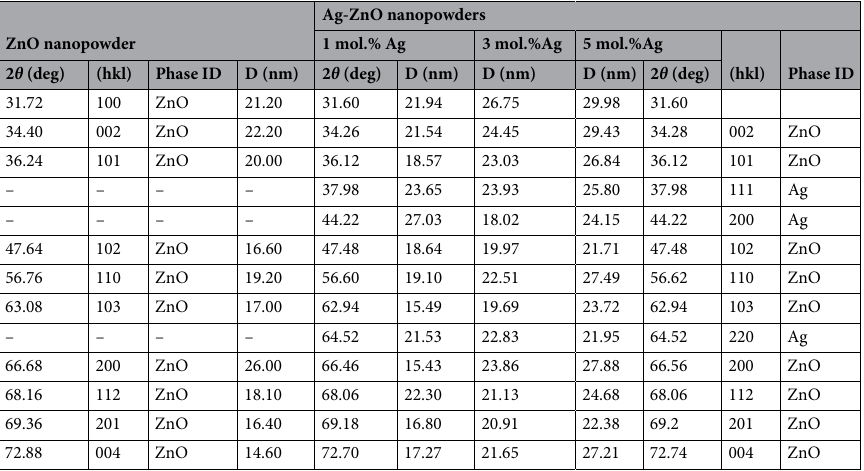
Table 2. 2 θ , hkl , phase ID and crystallite size ( D ) of pure ZnO and Ag doped ZnO nanopowders as presented in XRD patterns analysis.